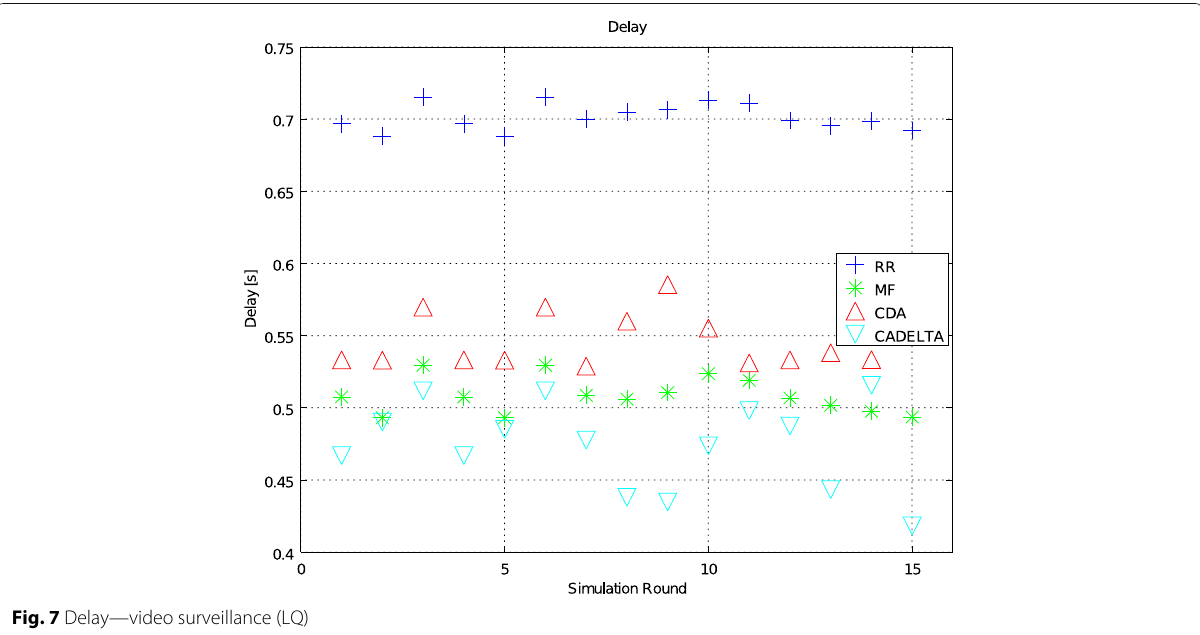
presented in this work, the average fairness is never lower than 0.6. Meanwhile, CADELTA is more sensible; in fact, in different network traffic loads, it is possible to observe that the average fairness span between 0.5 (more inten- sive traffic in the network) and 1 (less intensive traffic in the network). However, regardless the network’s traf- fic, CADELTA is the best performing in terms of delays and CDA is the best performing in terms of